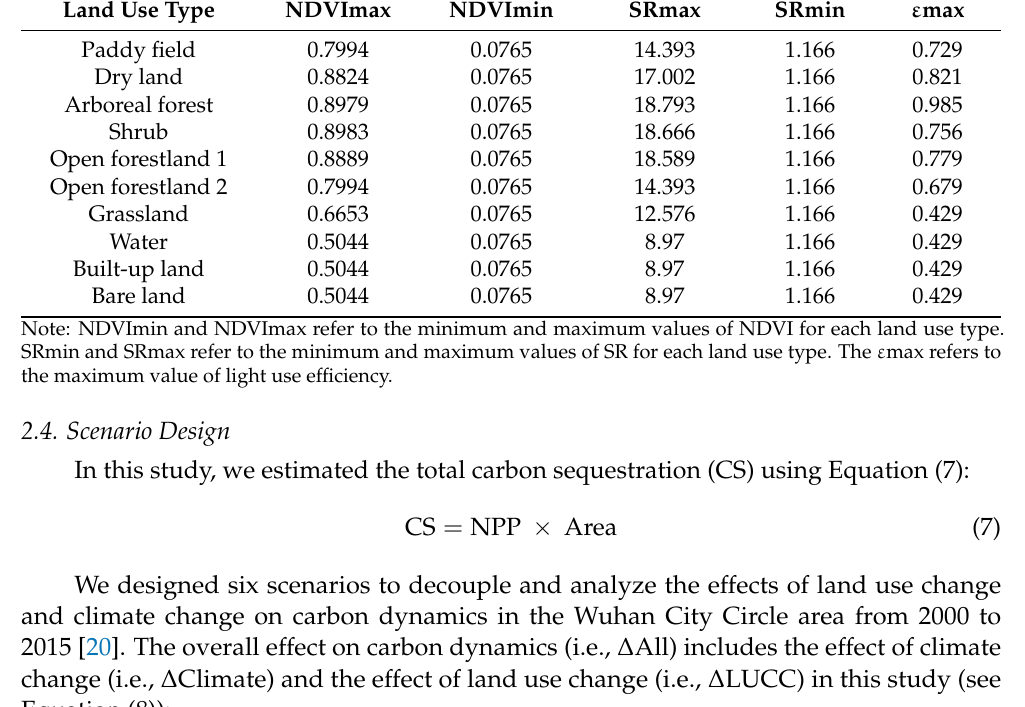
Table 2. Parameters of the CASA model for different land use types in the Wuhan City Circle area. Land Use Type NDVImax NDVImin SRmax SRmin ε max Paddy